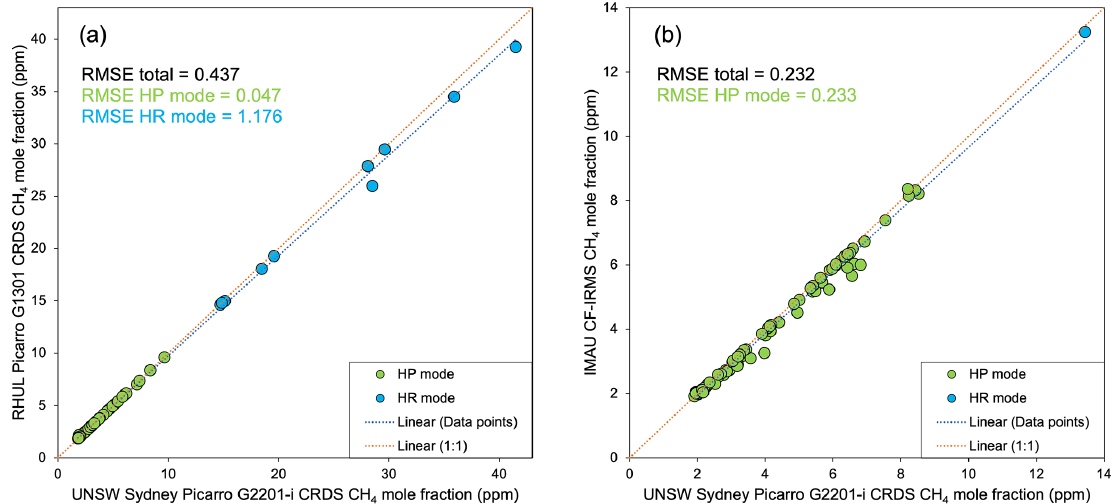
Figure A1. Cross-plots of CH 4 mole fraction values measured from bag samples using the UNSW Sydney Picarro G2201-i CRDS and the RHUL Picarro G1301 CRDS (a) in 2018 and the UNSW Sydney Picarro G2201-i CRDS and IMAU CF-IRMS (b) in 2019.